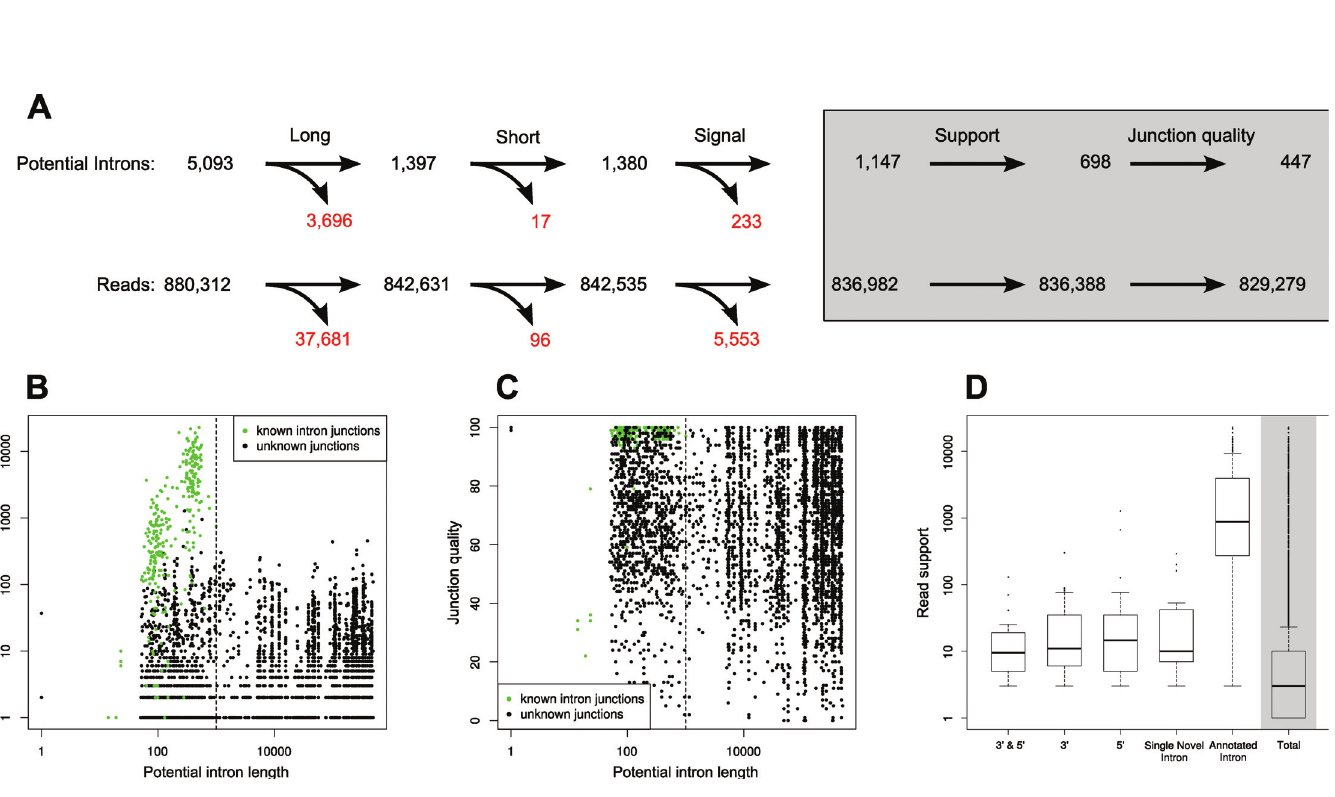
Fig 1. Split read mapping and AS in genes with one intron. We show the important alternative transcript models together with their idealized read coverage in next generation sequencing data. Models of all AS events described in the text are outlined in S5 Fig. The black line represents the total read coverage of all mapped reads. The green, red and blue lines represent characteristic reads for certain isoforms. (A) Split reads defining an intron. Reads r1 through r4 are mapped to the genome in a spliced fashion; the potential intron is supported by 4 reads. Reads r1 and r2 represent the same fragment, because they have exactly the same sequence and hence the same start and end position on the genome. As a result, the potential intron is supported by three distinct fragments. (B) Intron retention. The total read coverage (black) drops in the area of the intron and the intronic area is spanned by split reads (green). Ungapped (red) reads containing the 3 ’ or 5 ’ splice site are evidence of the unspliced transcript. (C) Alternative 3 ’ splice site. The total read coverage is lower in the intron, but shows an increase towards the 3 ’ site. There are two different types of overlapping split reads (green and blue), using the same 5 ’ splice site, but different 3 ’ splice sites. Alternative 5 ’ splice sites show an analogous, mirrored read coverage. Any combination of alternative 3 ’ and alternative 5 ’ splice sites is possible. (D) Actual read data for the gene YBL026W. The total read coverage is shown for 6 different sequencing runs (colored lines). The low read coverage within the intron and the elevated read coverage on the 3 ’ side of the intron are clearly visible, indicating an alternatively spliced isoform.